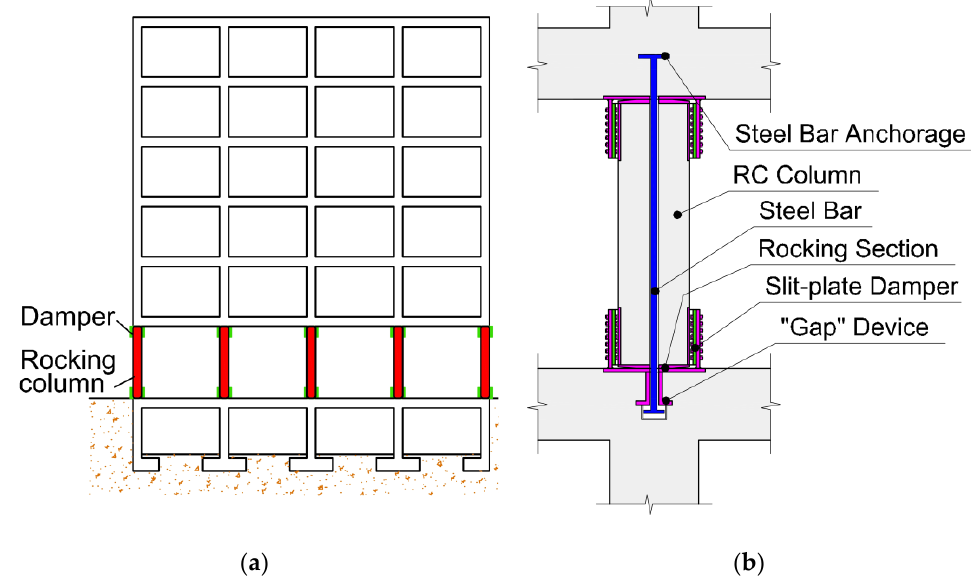
Figure 2. Reinforced concrete (RC) frame structure with rocking columns and slit-plate dampers: ( a ) Elevation of the RC frame; ( b ) detail of the rocking columns of the first story.